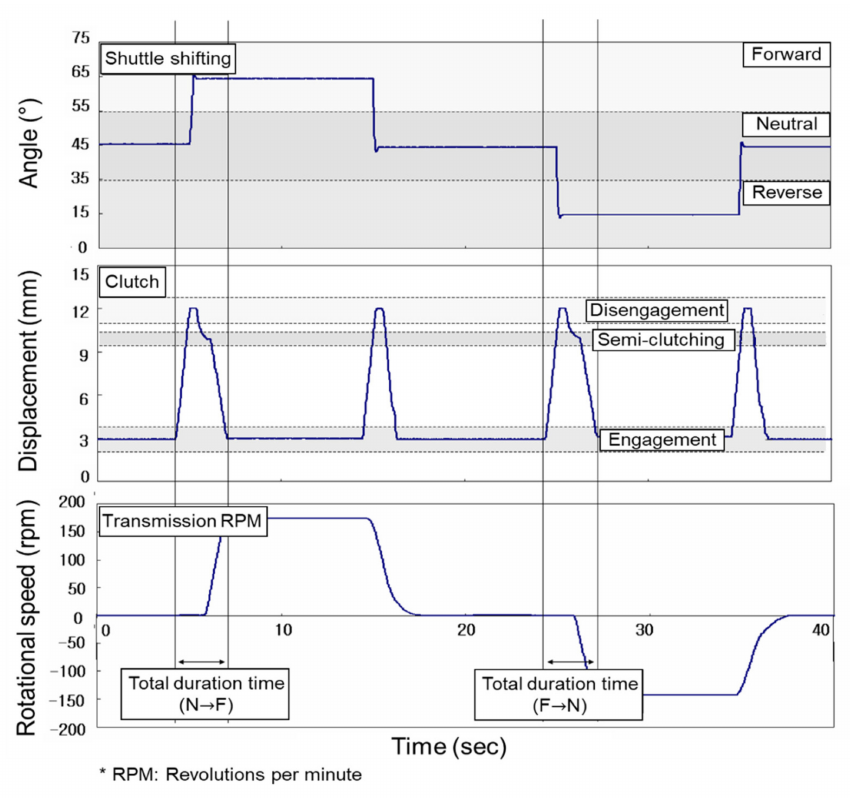
Figure 14. Results of automatic shuttle shifting control (range shift: 3rd, driving shift: 2nd). Table 6. Results of performance evaluation for automatic shuttle shifting control according to shifting conditions and each gear